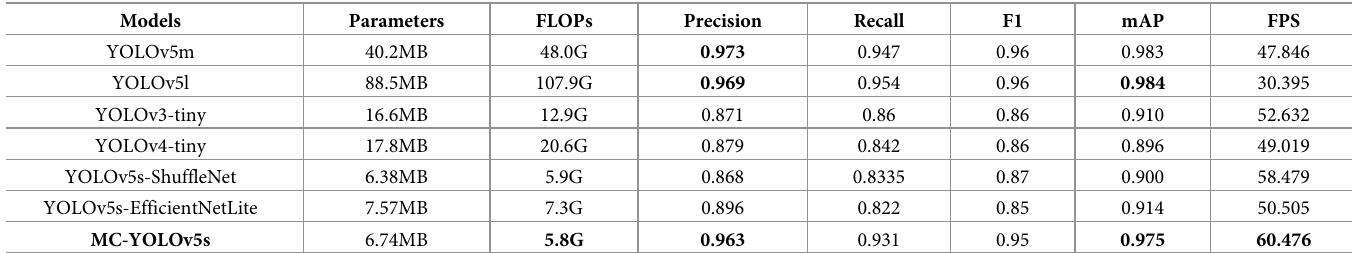
Table 5. Comparison of the performance of the models on the validation set.